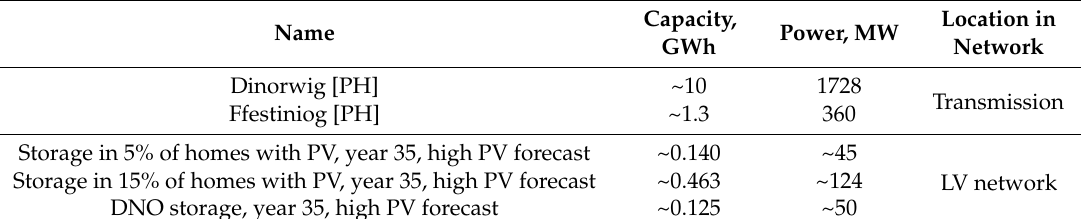
Table 4. Comparison between distributed storage to existing pumped hydro (PH) and battery systems in the UK. LV storage is rated for 5 h and shown only for homes in the ENWL license area.